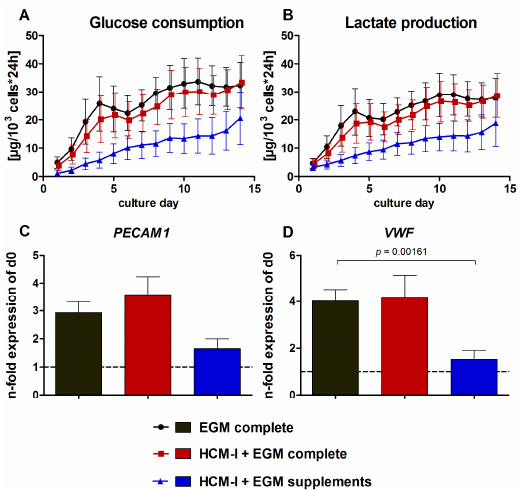
Figure 2. Effect of different media compositions on mono-cultures of human umbilical vein endothelial cells (HUVEC). The cells were cultured over 14 days in endothelial cell growth medium, consisting of basal medium and supplements (EGM complete), in a 1:1 mixture of hepatocyte culture medium and EGM complete (HCM-I + EGM complete) or in HCM enriched with endothelial cell growth supplements (HCM-I + EGM supplements). The graphs show time-courses of glucose consumption ( A ) and lactate production ( B ) as well as gene expression analyses of the endothelial cell markers platelet endothelial cell adhesion molecule 1 ( PECAM1 ) ( C ) and von Willebrand factor ( VWF ) ( D ). Fold changes of mRNA expression were calculated relative to HUVEC before starting the experiments (d0) with normalization to glyceraldehyde-3-phosphate dehydrogenase ( GAPDH ) expression by the ∆∆ C t method. The area under the curve was calculated for time-courses of biochemical parameters and differences between groups were detected using the unpaired, two-tailed Student’s t -test; for glucose consumption and lactate production n = 6, gene expression analysis n = 3, mean ± standard error of the mean.